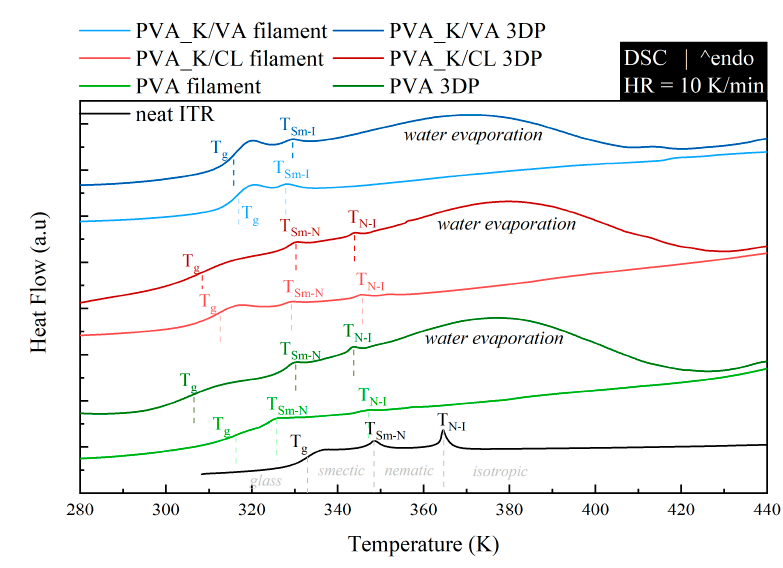
Figure 3. DSC thermograms of neat ITR and its mixtures with PVA, PVA_K/VA, and PVA_K/CL prepared in two forms: filament and 3DP tablet. Table 3. Comparison of values of T g , T Sm-N , and T N-I of neat ITR and its mixtures with PVA, PVA_K / VA, and PVA_K / CL which were prepared in two forms: filament and 3DP